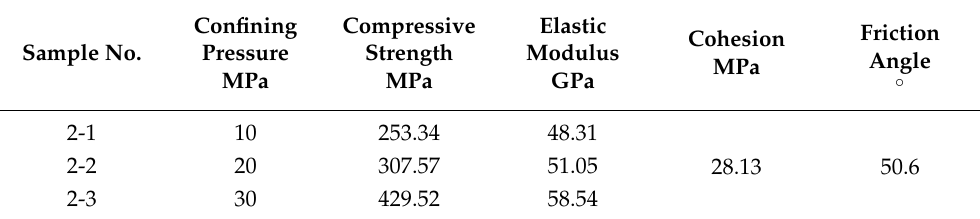
Figure 16. Comparison of rupture in uniaxial test and biaxial results, ( a ) biaxial compression test, ( b ) Single-axis compression results. Table 2. Macro parameters of biaxial compression test.